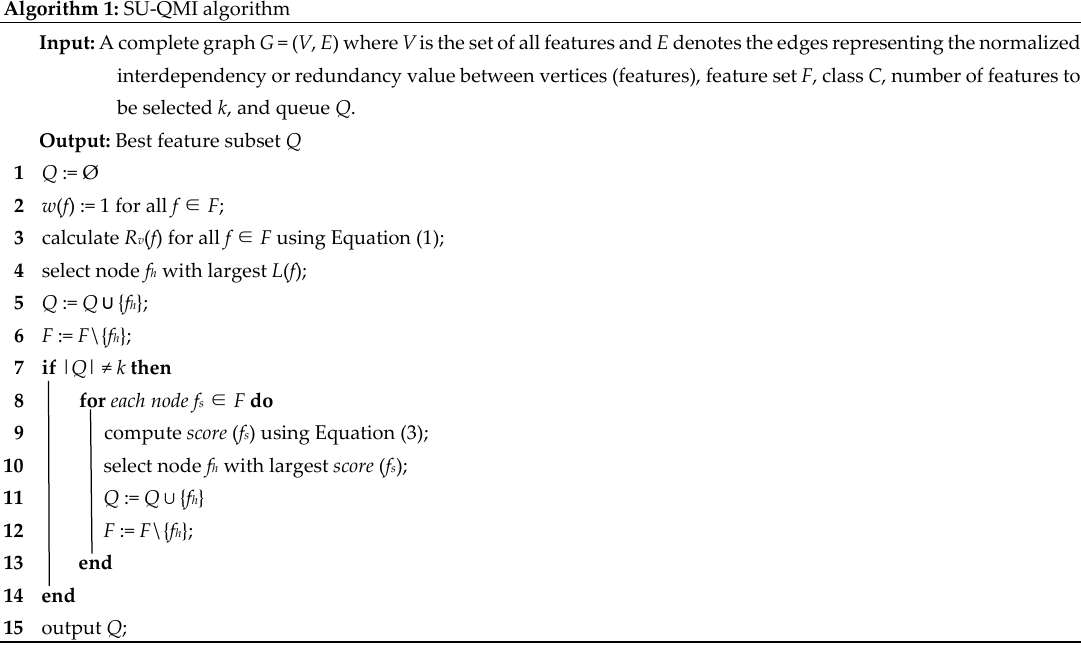
Algorithm 1: SU-QMI